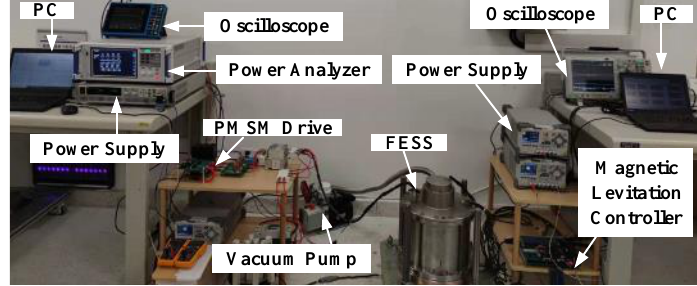
Figure 11. The experimental platform of the 8 kW FESS prototype.